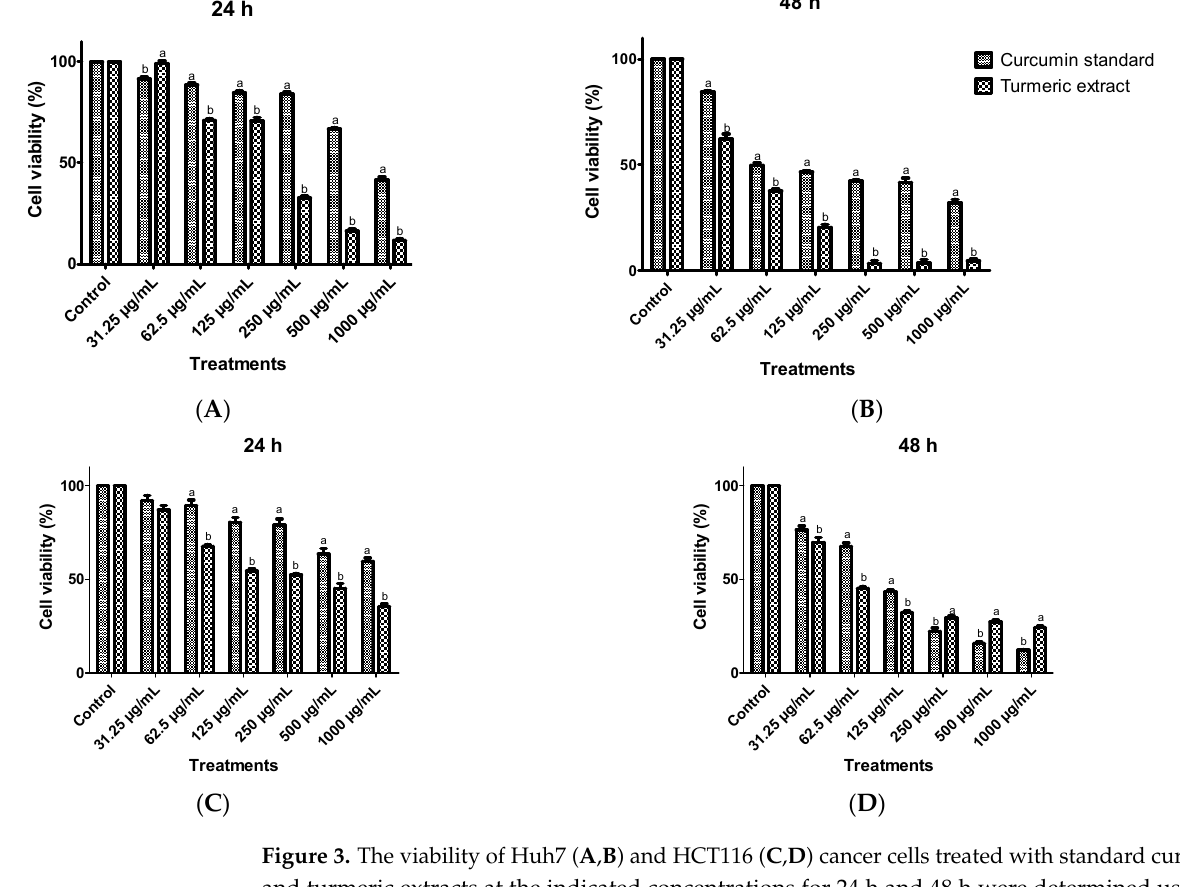
Figure 3. The viability of Huh7 ( A , B ) and HCT116 ( C , D ) cancer cells treated with standard curcumin and turmeric extracts at the indicated concentrations for 24 h and 48 h were determined using an MTT assay a–b ( p < 0.001) .